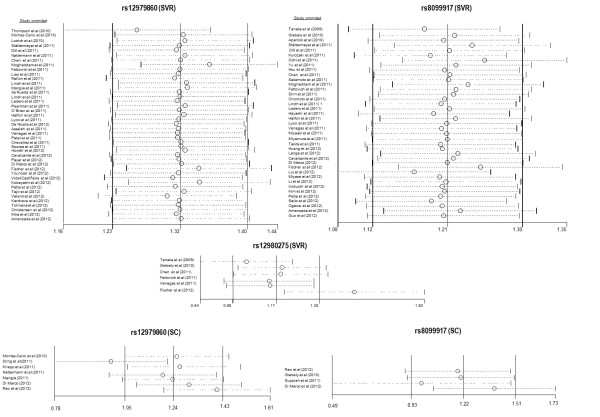
Sensitivity analysis for rs12979860, rs8099917, and rs12980275 for sustained virologic response (SVR), and rs12979860 for spontaneous clearance (SC). Sensitivity analyses were carried out to investigate the influence of any one study on the overall meta-analysis by sequential omission of individual studies.